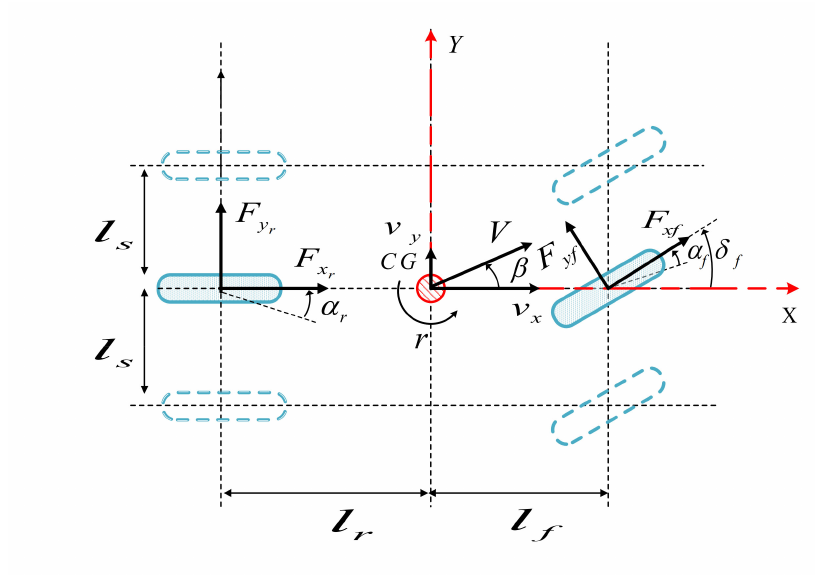
Figure 1. The simplified vehicle lateral